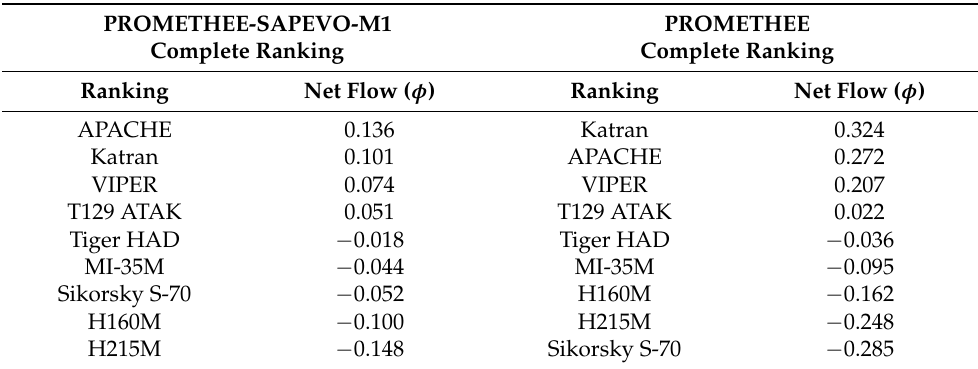
Table 17. Complete ranking in PROMETHEE-SAPEVO-M1 and PROMETHEE